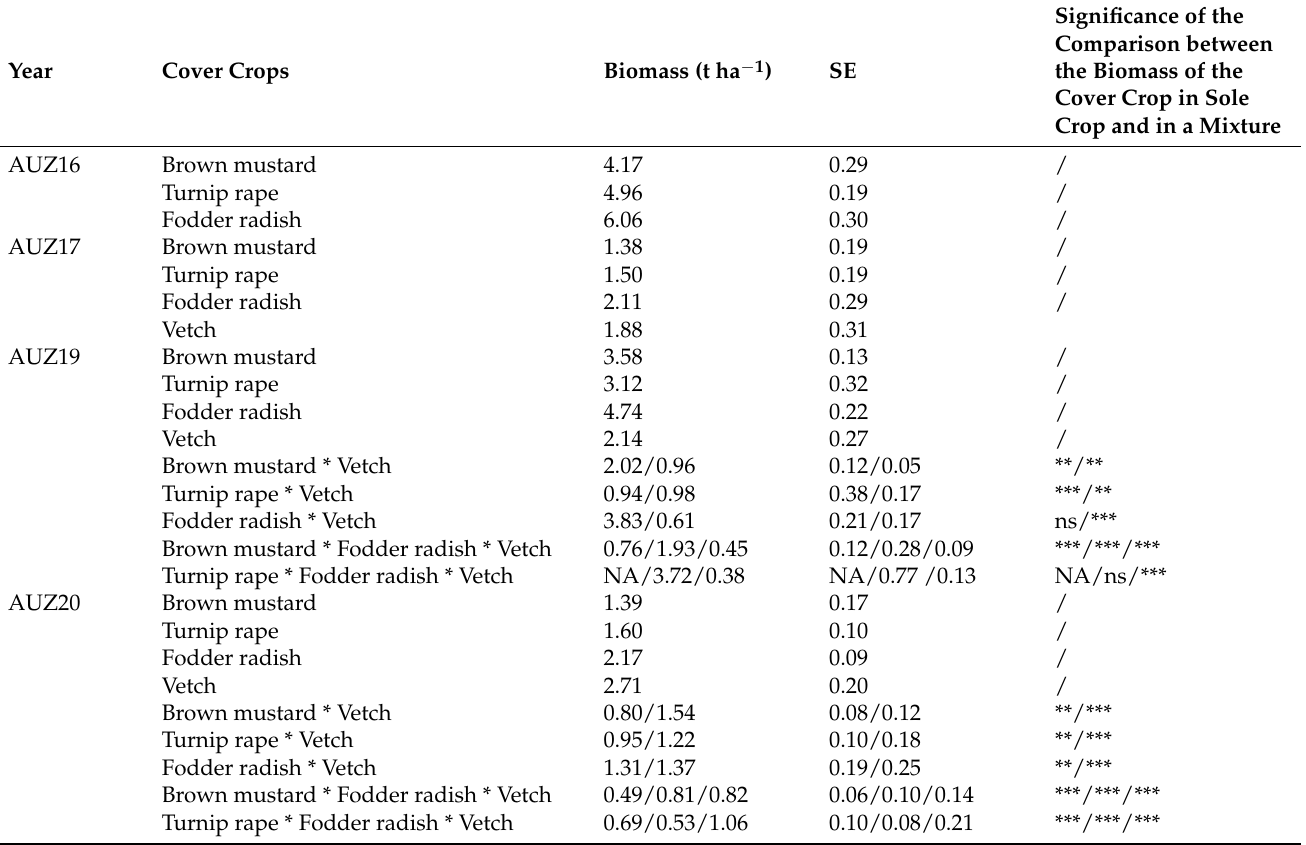
Table A1. Dry matter biomass (t ha − 1 ) of each cover crops species in sole crops and in a mixture of two or three species measured at the destruction of the cover crop, in 2016, 2017, 2019 and 2020. SE represents the standard error. Abbreviations ns, *, **, *** indicate non-significant, or significant differences at p < 0.05, 0.01 or 0.001, respectively. NA indicate non applicable (no data available